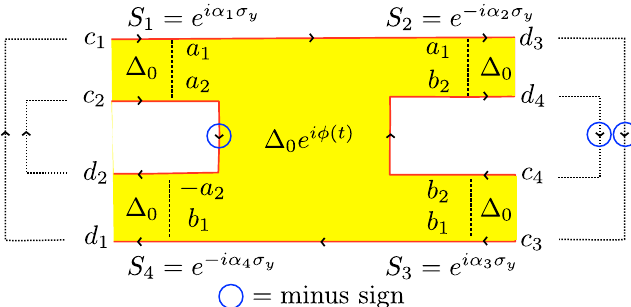
Figure 6: Labeling of incoming and outgoing Majorana edge modes in a four-terminal Josephson